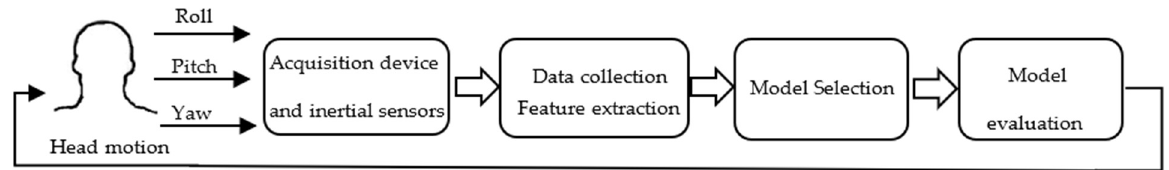
Figure 9. Workflow for implementing head motion recognition solutions based on inertial sensors.